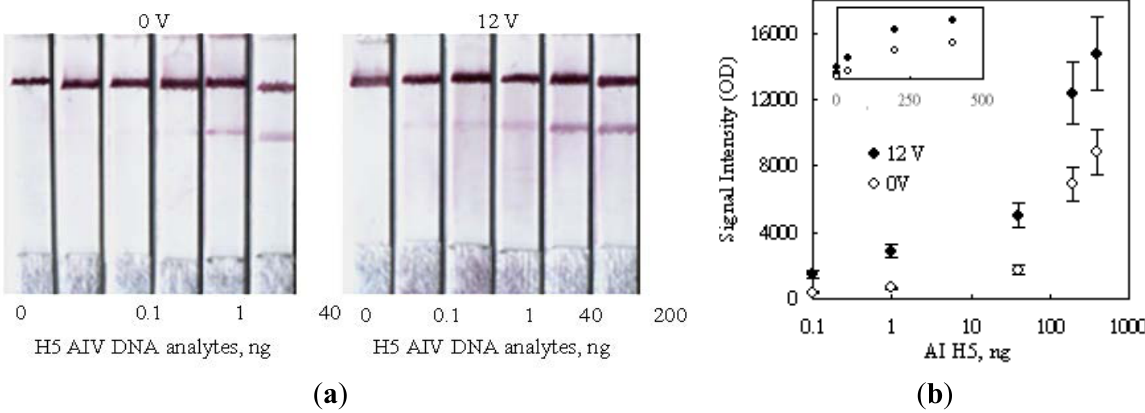
Figure 8. The sensitivity test of electric-field enhanced MBLF strips. ( a ) Left: detection sensitivity on MBLF strips without voltage applied; Right: 12 V was applied. Width of all strips was 5 mm. ( b ) The corresponding quantitative analysis of the signal intensities. The top small inset was identical to the big one but plotted on a linear scale for the horizontal axis. The big chart was plotted in a logarithm scale to show the detailed information of the low-quantity